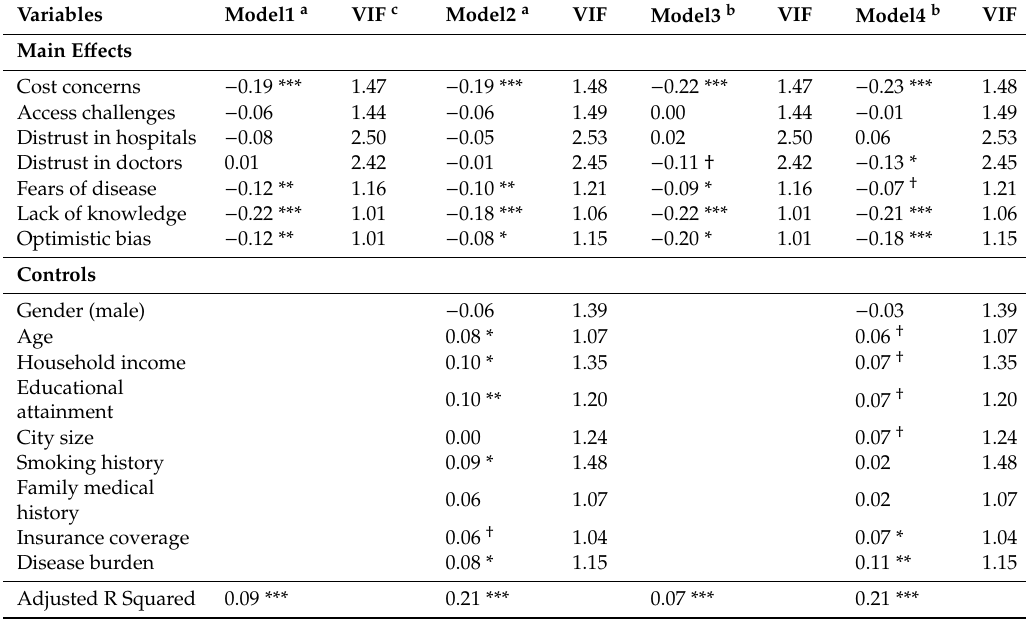
Table 3. Standardized Ordinary Least Squares Regression predicting intention to learn about and uptake Low-Dose Computed Tomography (LDCT) Lung Cancer Screening ( N =